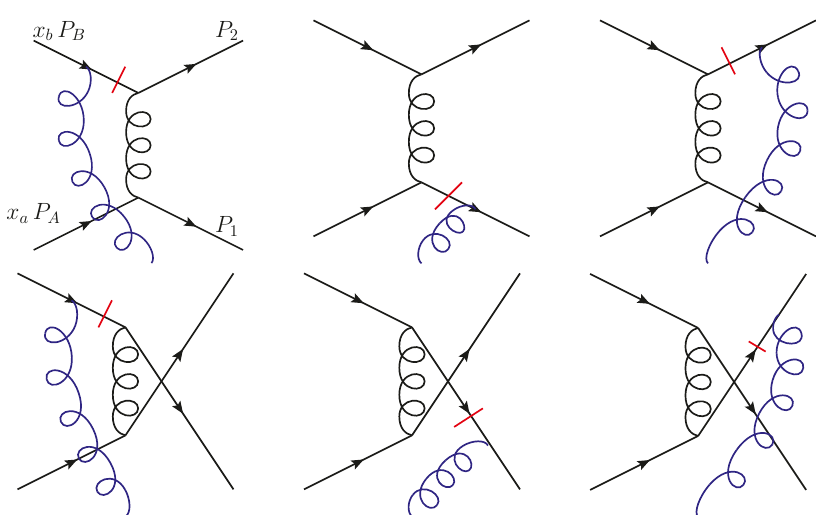
Figure 5 . Polarized scattering amplitudes for the qq → qq subprocess. From left the right, the first three graphs give the scattering amplitude for the t -channel for initial-state, final-state 1, and final-state 2 interactions. The remaining channels give the contributions for the u -channel for initial-state, final-state 1, and final-state 2